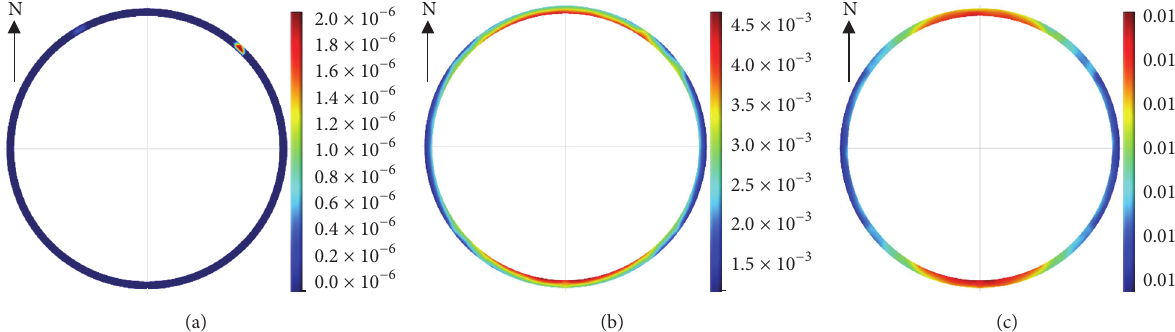
Figure 15: Effective plastic strain of the concrete layer at − 3 m level after 5 weeks (a), 10 weeks (b), and 16 weeks (c) of heating.